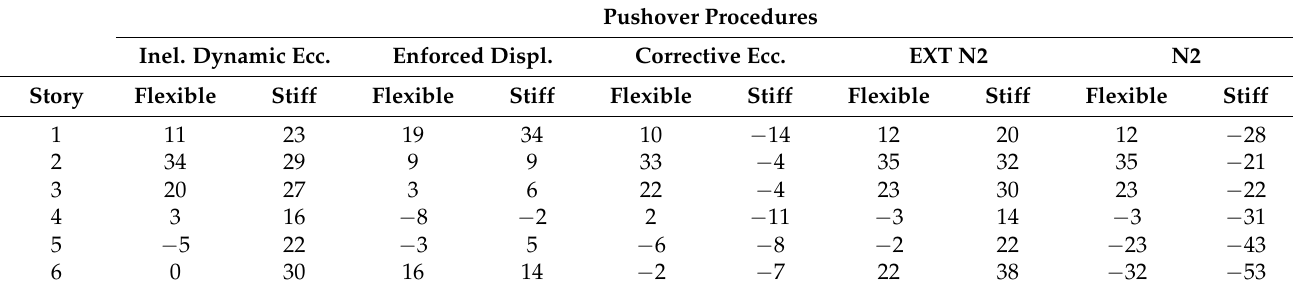
Table 7. Error (%) on the seismic floor angular deformations γ Isec at the stiff and flexible sides along the I sec axis resulted from the examined pushover procedures for case 2 building. Pushover Procedures Inel. Dynamic Ecc. Enforced Displ. Corrective